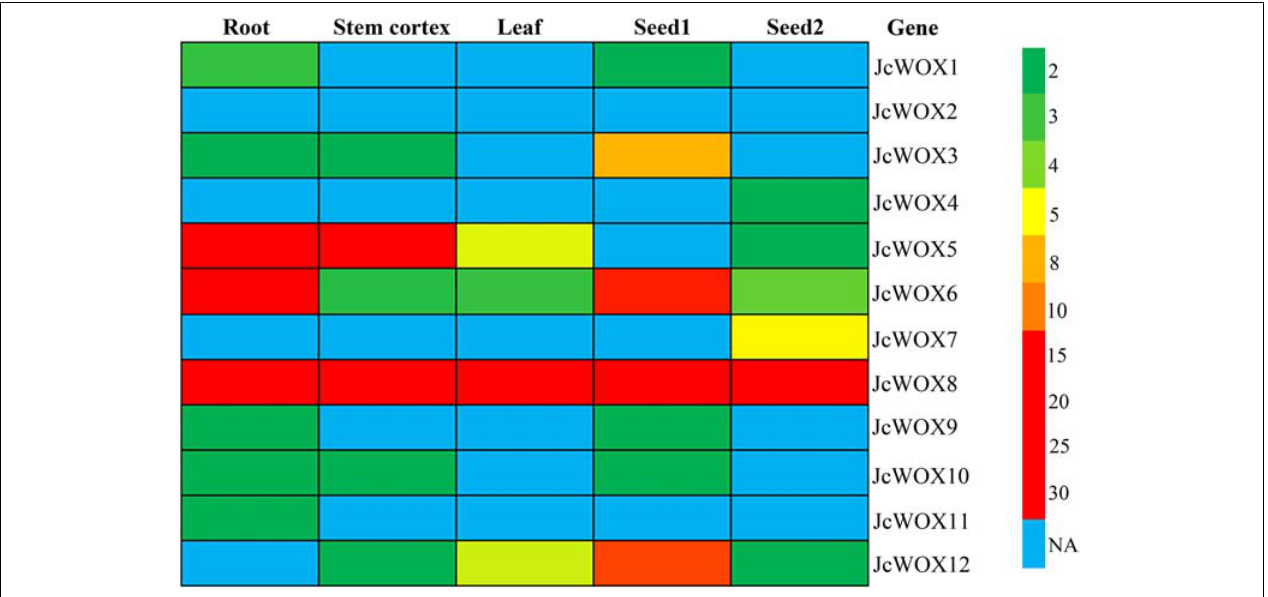
FIGURE 4 | Expression profiles of JcWOX5 . Patterns of expression of each JcWOX gene in physic nut roots, stem cortex, leaves, and seeds at an early developmental stage (S1) and filling stage (S2), with a colored scale indicating expression levels shown on the right.